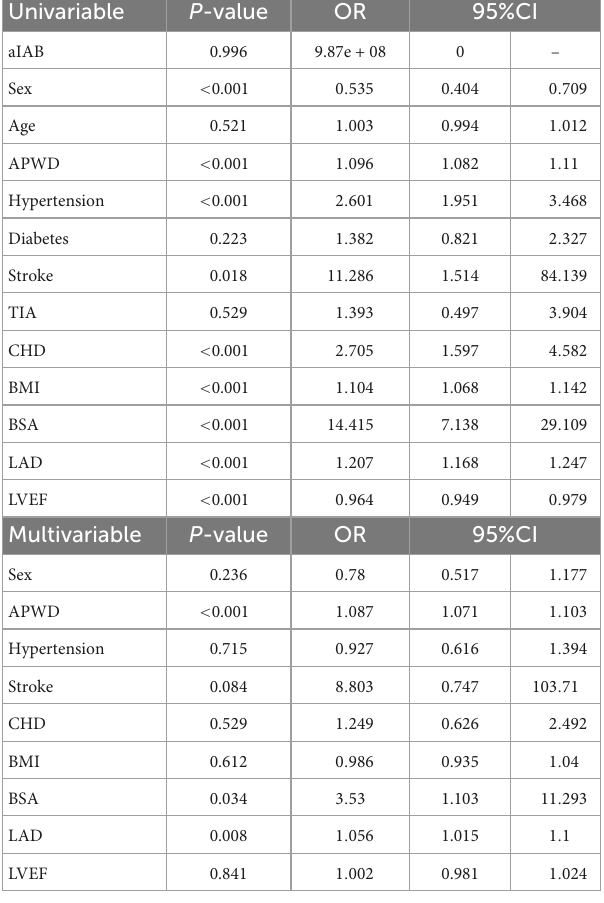
TABLE 2 Univariable and multivariable analysis of AF